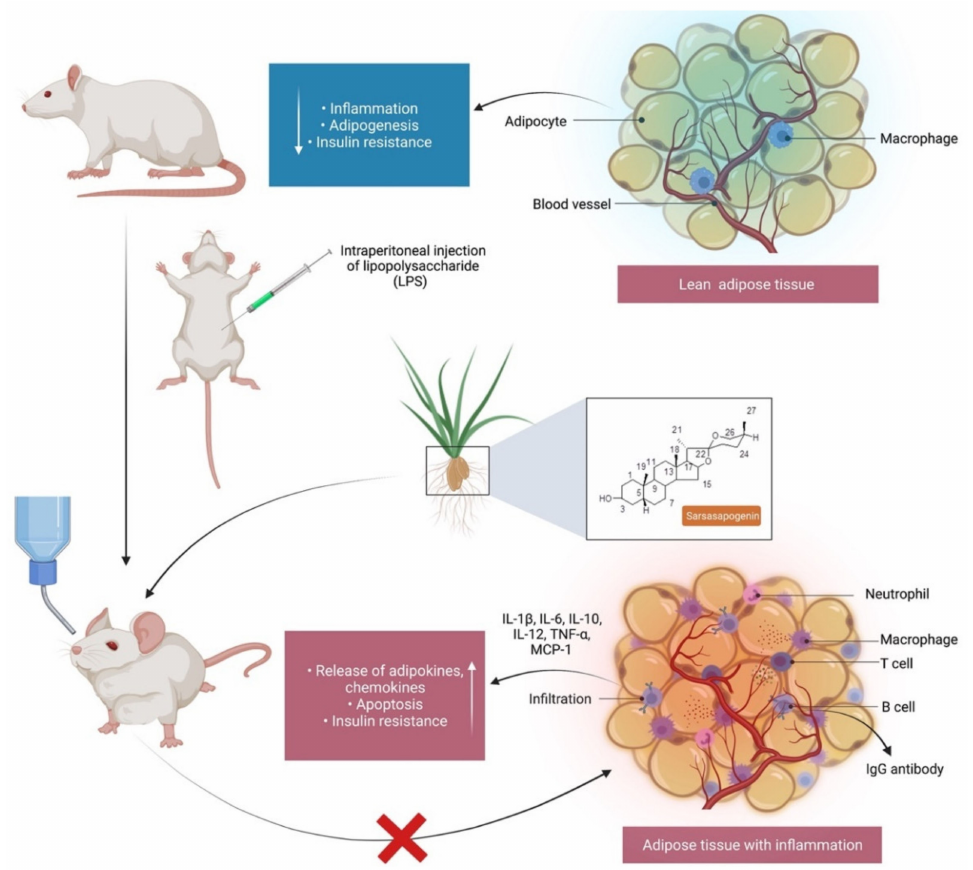
Figure 3. Sarsasapogenin’s anti-inflammatory action in adipose tissue. While lean adipose tissue contributes to metabolic balance, inflammation regulation and insulin resistance, as obesity pro- gresses, adipocytes enlarge and release adipokines, resulting in an increase in the production of pro-inflammatory factors and immune cell infiltration. Sarsasapogenin has been shown to inhibit pro-inflammatory cytokines, such as TNF- α , IL–1 β , IL–6, IL-10, IL-12 and MCP-1, in white adipose tissue. TNF- α , tumour necrosis factor alpha; interleukin-1 beta, -6, -10 and -12; MCP-1, monocyte chemoattractant